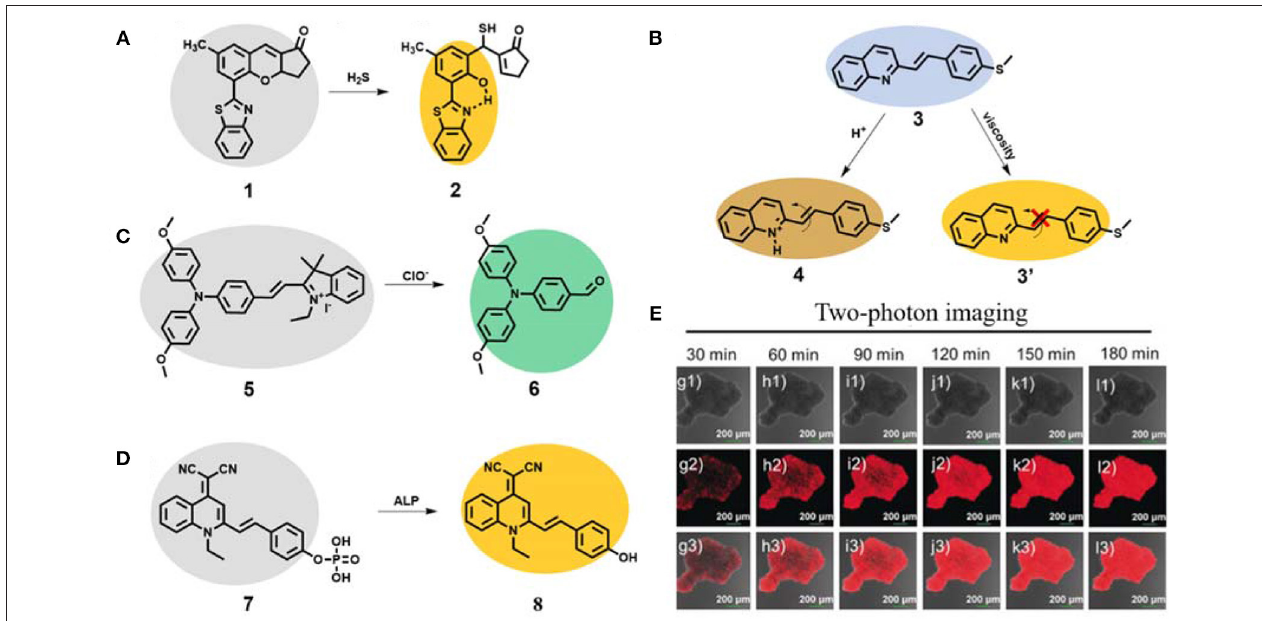
FIGURE 2 | (A) Working principle of AIE probe 1 for fluorescent two-photon detection of H 2 S. (B) Working principle of AIE probe 3 for fluorescent two-photon detection of pH and viscosity. (C) Working principle of AIE probe 5 for fluorescent two-photon detection of ClO − . (D) Working principle of AIE probe 7 for fluorescent two-photon detection of ALP and (E) two-photon imaging of HeLa multicellular tumor spheroids (reproduced with permission from Li H. et al., 2020; Copyright 2020 Wiley-VCH.).